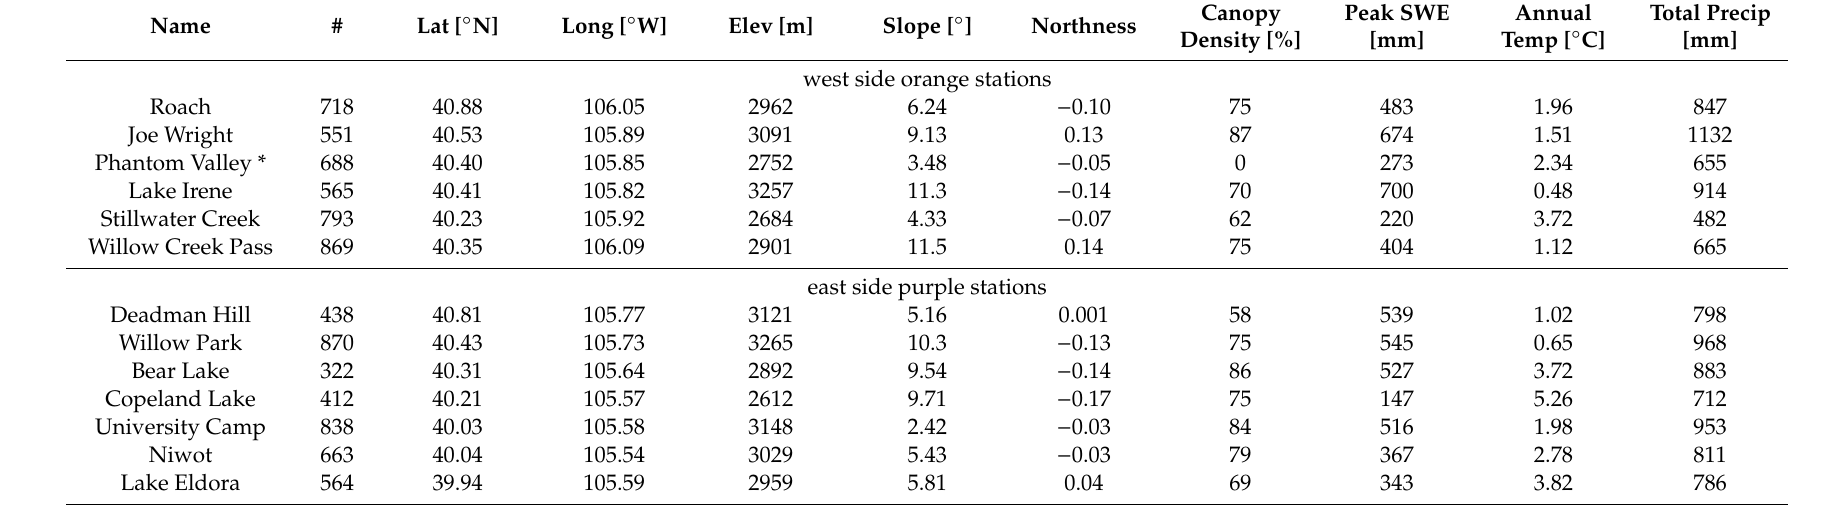
Table 1. The characteristic of the 13 SNOTEL stations (see Figure 1a) including station number (#), and location: latitude (lat), longitude (long), and elevation (elev). The slope and northness (sine slope x cosine aspect) are derived from the U.S. Geological Survey National Elevation Dataset. The canopy density is from the U.S. Geological Survey National Land Cover Database (NLCD). The NLCD land cover is evergreen forest for all stations, except * Phantom Valley that is denoted as developed, open space. The mean peak snow water equivalent (SWE), mean annual temperature (temp), and mean annual precipitation (precip) are from the SNOTEL station